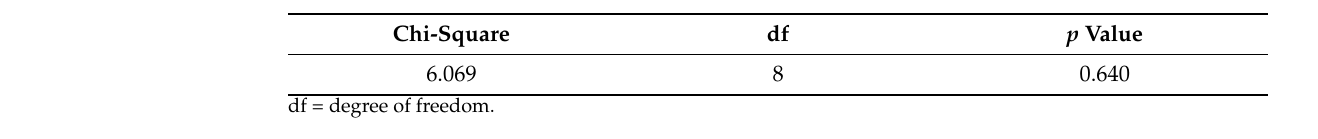
Table 10. Hosmer dan Lemeshow test.